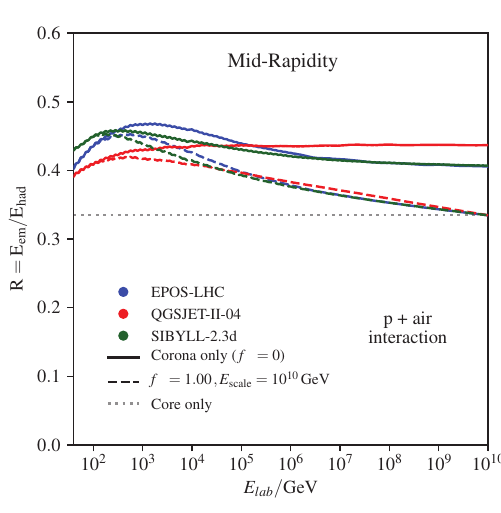
Figure 6. Evolution of the ratio R from pure corona to pure core in the case of a linear increase of core fraction as a function of the logarithm of the energy for three di ff erent models in proton-air interactions at